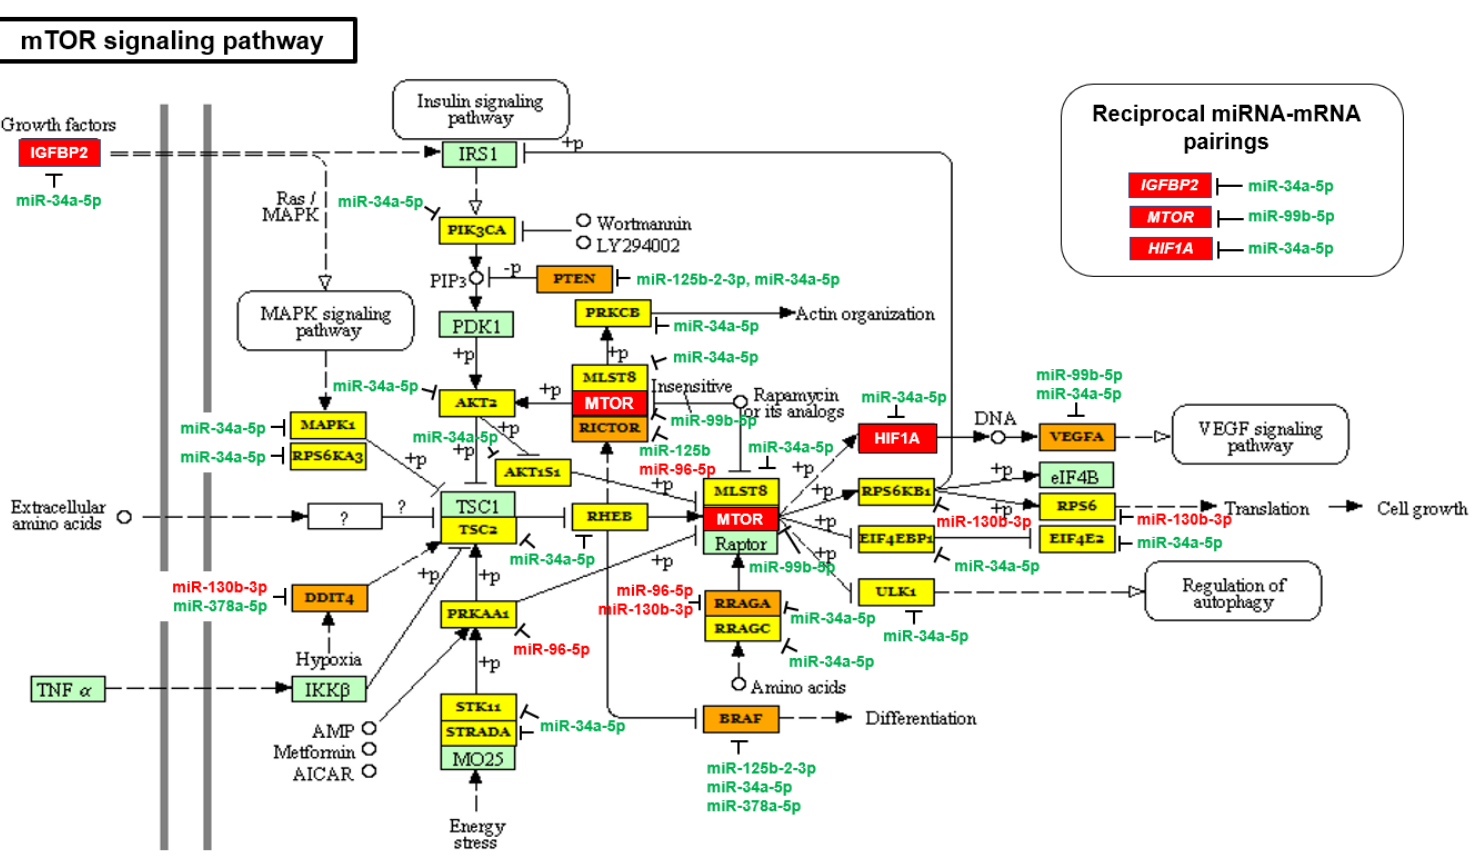
Figure 5. The mTOR signaling pathway is upregulated in AA prostate cancer (PCa) specimens. MirPath v.3 was used to evaluate the impact of the 10 differentially expressed miRNAs (in AA PCa vs. EA PCa) in regulating the biological signaling pathways in AA PCa compared to EA PCa. Downregulated (green) and upregulated (red) miRNAs and mRNAs, in AA PCa vs. EA PCa, were indicated in mTOR signaling pathway. Three robust reciprocal miRNA-mRNA pairings, IGFBP2 /miR-34a-5p (up/down), MTOR /miR-99b-5p (up/down) and HIF1A /miR-34a-5p (up/down), were highlighted. Unpaired AA-depleted miRNAs (miR-125b-2-3p, miR-378a-5p and miR-34a-5p) and AA-enriched miRNAs (miR-130b-3p and miR-96-5p) were indicated adjacent to their predicted target genes. The genes highlighted with yellow are genes targeted by one AA-depleted/enriched miRNA. The genes highlighted with orange are genes targeted by at least two AA-depleted/enriched miRNAs. The genes highlighted with light green are genes not targeted by any AA-depleted/enriched miRNA.